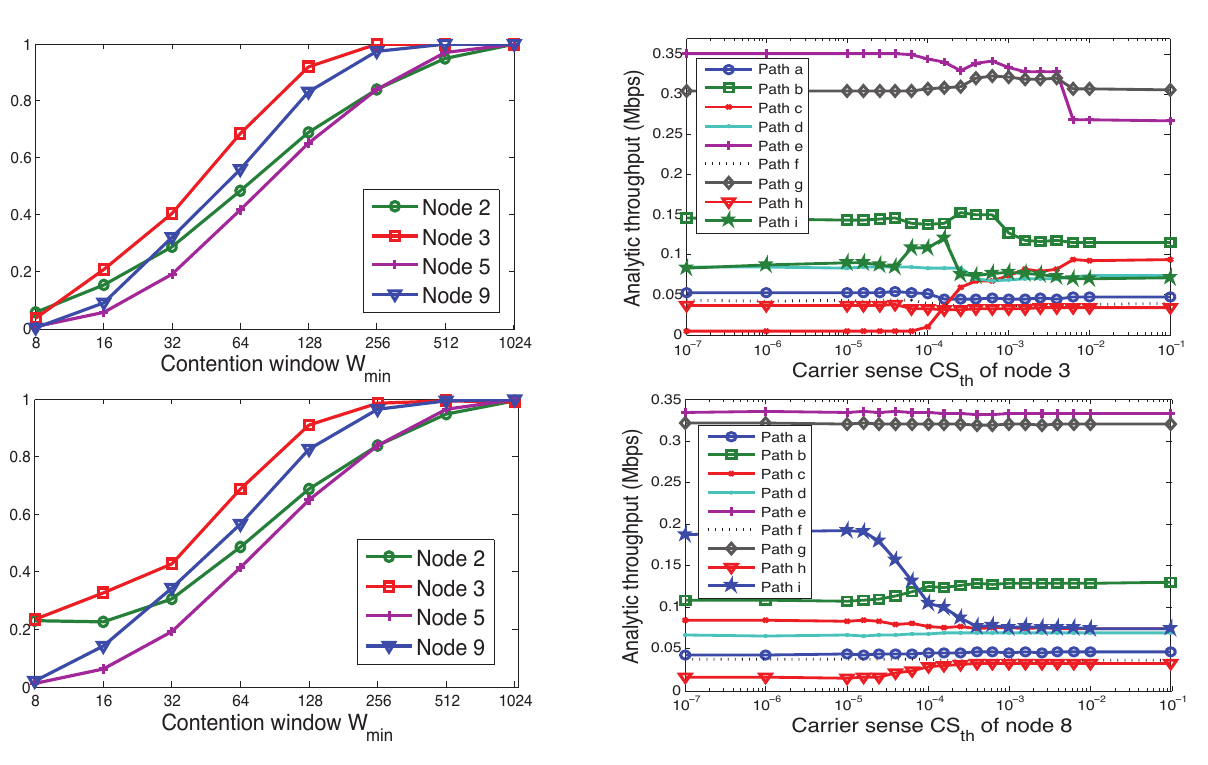
Figure 10. Average load of forwarding queues from model versus simulation when varying the minimum contention window.